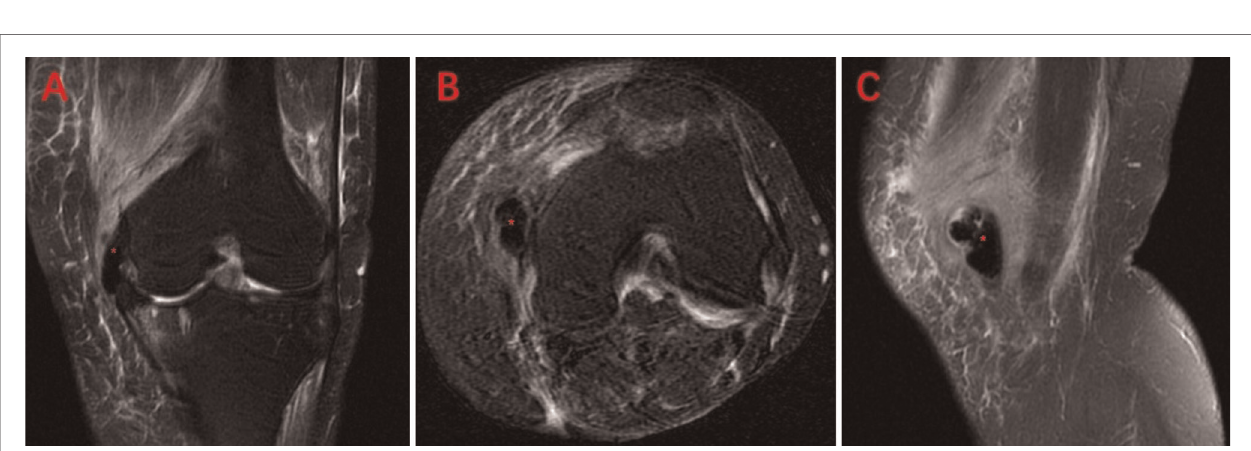
FIGURE 2 | Preoperative MRI of the left knee. ( A ) Coronal T2 weighted image (T2WI); ( B ) transverse axis proton density weighted image (PDWI); ( C ) sagittal T2WI. *Pellegrini – Stieda